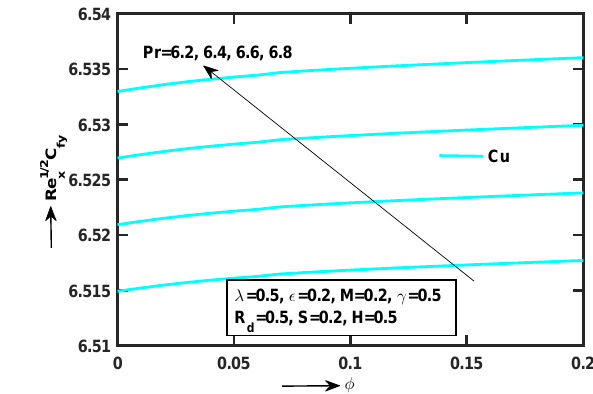
Figure 9: Significance of R d on θ ( η )